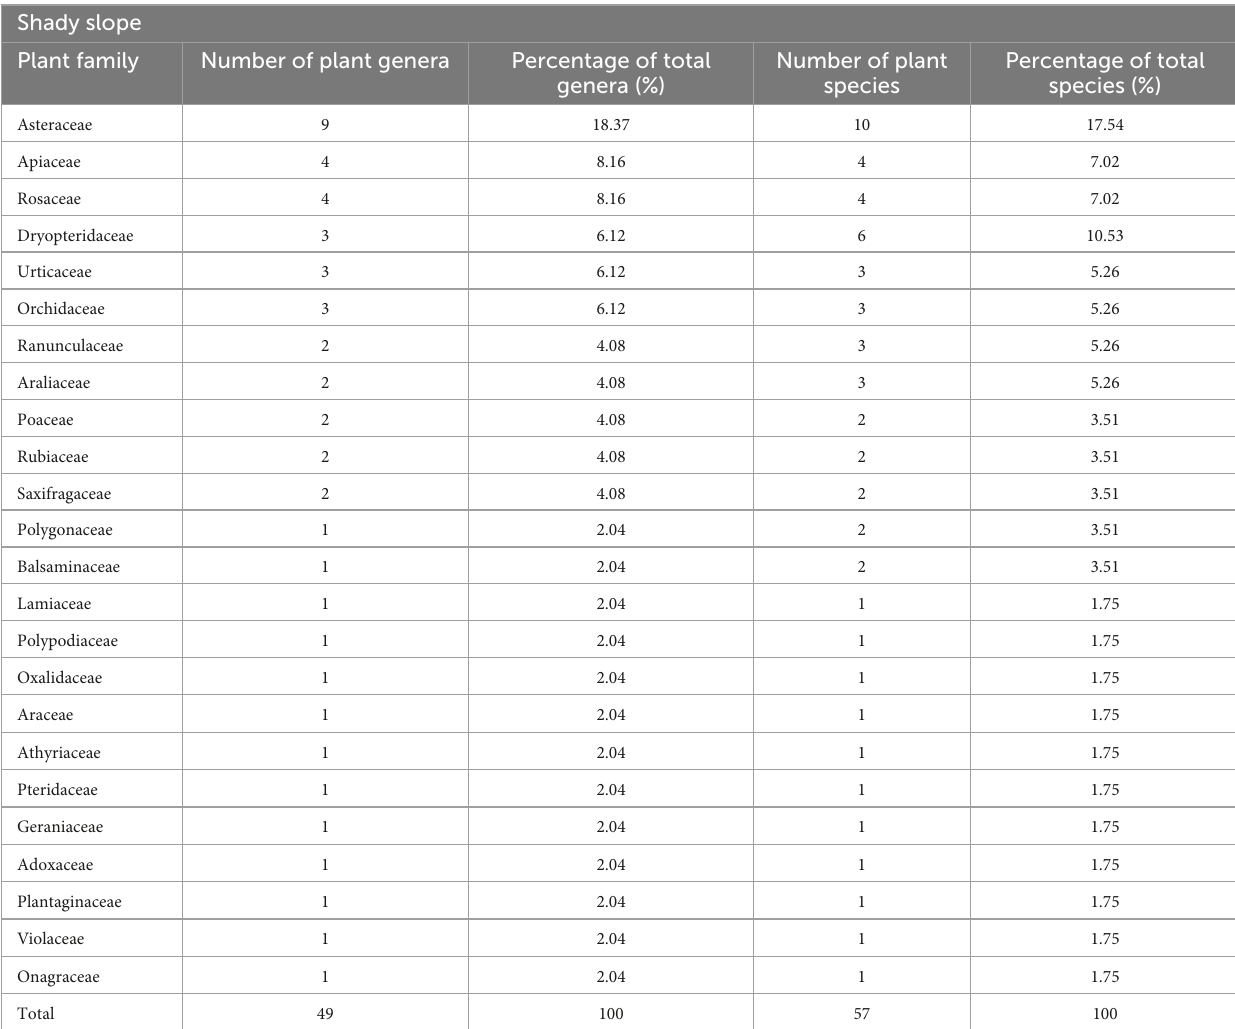
TABLE 2 Composition of herbaceous plants on shady